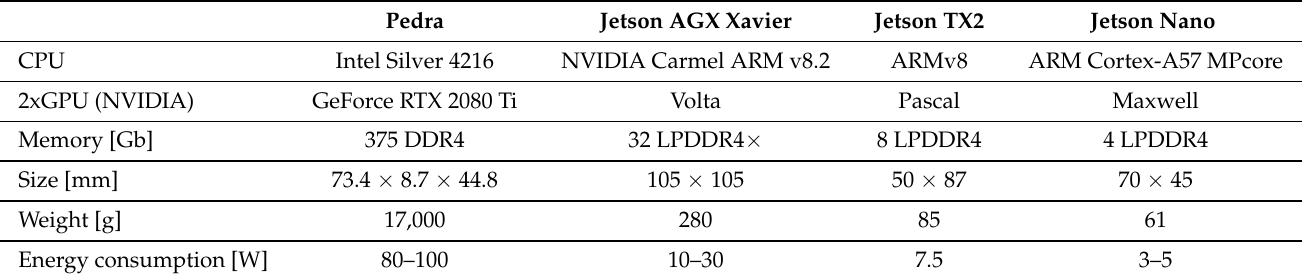
Table 1. Hardware details of the hardware used in our